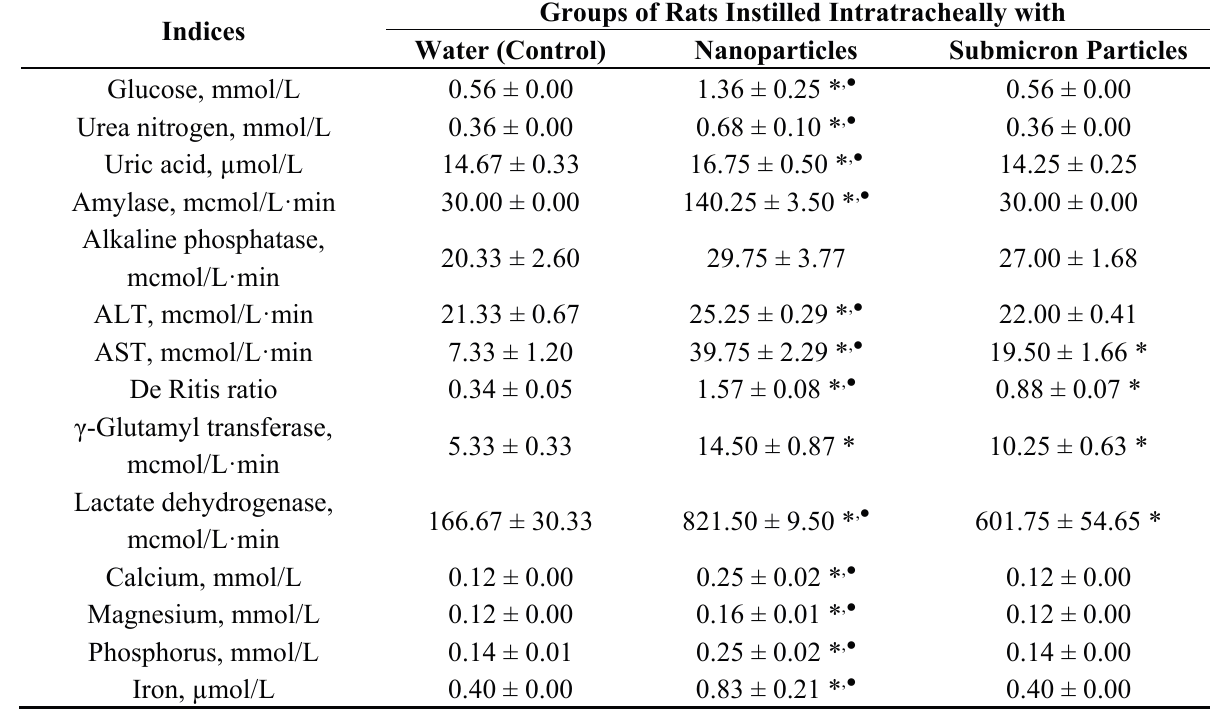
Table 2. Some biochemical characteristics of the supernatant of the fluid obtained